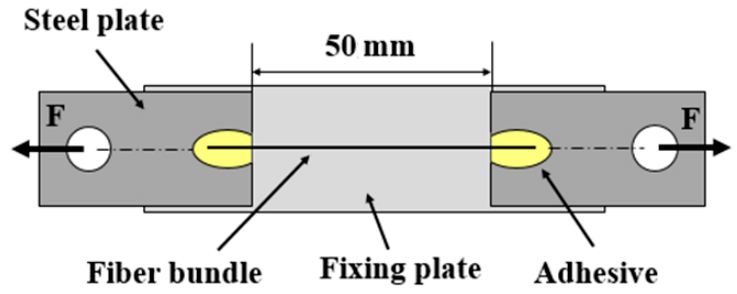
Figure 1. Schematic illustration of tensile specimen for single fiber bundles.